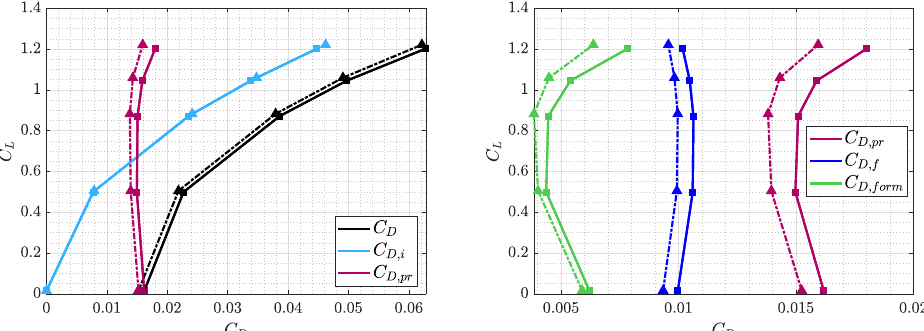
Figure 7. Drag breakdown for the isolated UAV wing ( left ), and focus on the profile drag ( right ). Solid lines with square markers indicate the clean configuration; dashed lines with triangular markers indicate the configuration with riblets.